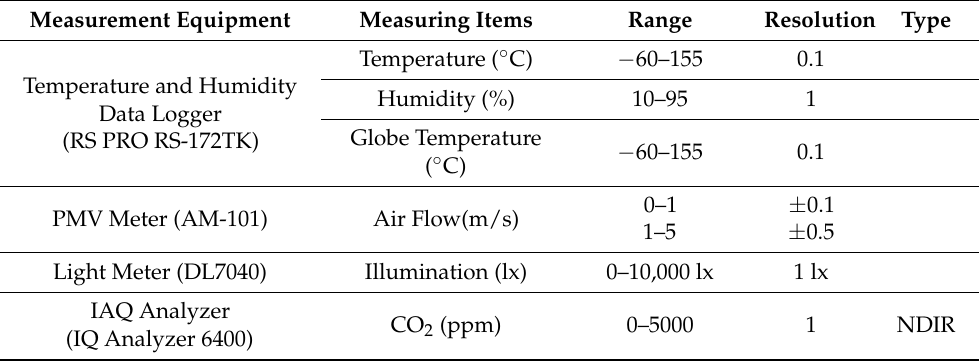
Table 2. Measurement